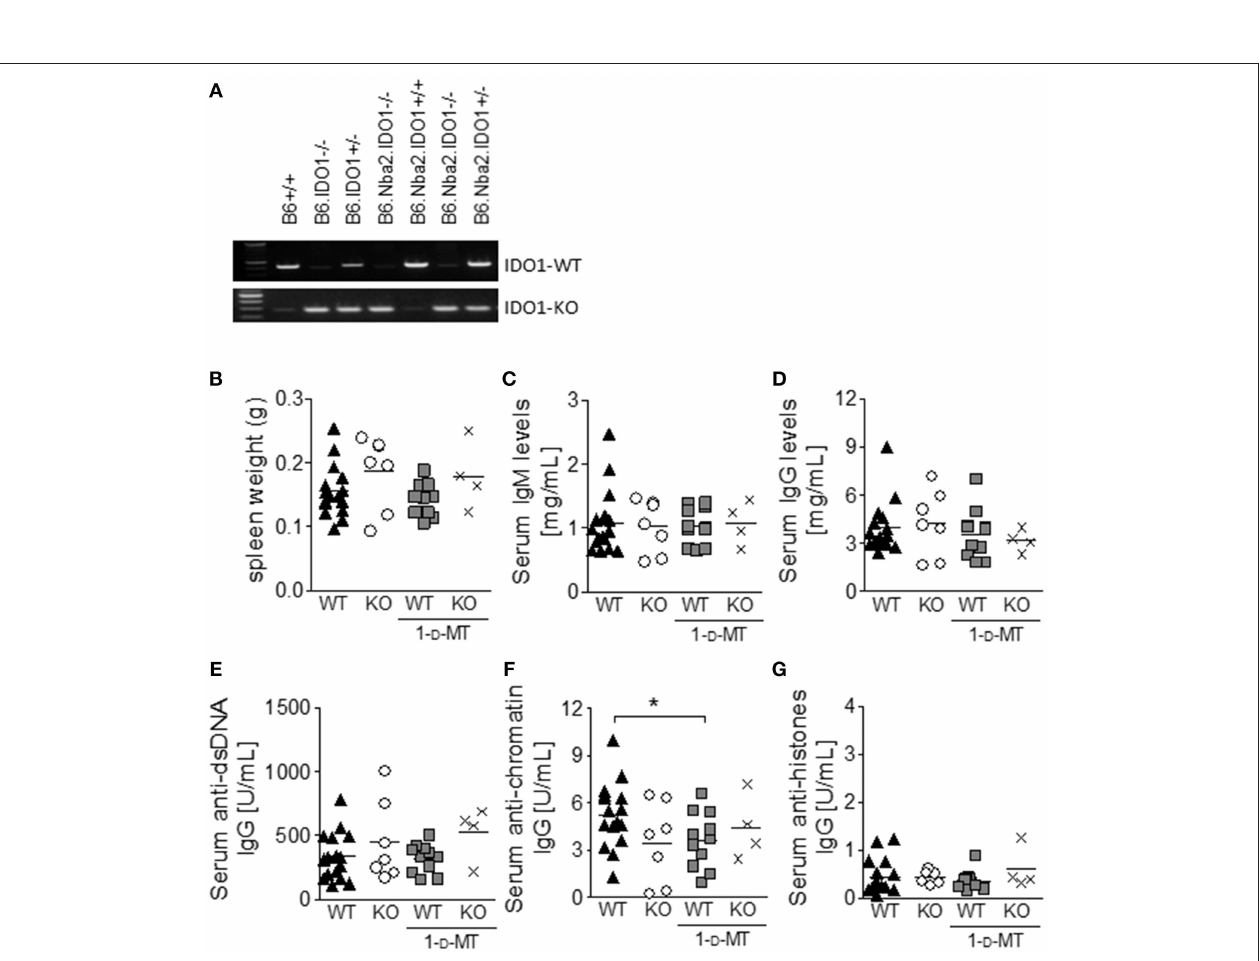
FIGURE 2 | IDO1-deficiency and/or 1- D -MT treatment do not affect the development of splenomegaly and autoantibody production in B6.Nba2 mice. IDO1-deficient and –sufficient B6.Nba2 mice were bred (A) and treated with PBS or 1- D -MT in the drinking water from 8 to 24 weeks of age. At 24 weeks of age, mice were harvested and spleen weights were recorded (B) . Serum was obtained monthly and evaluated for total IgM (C) , total IgG (D) , anti-dsDNA IgG (E) , anti-chromatin IgG (F) , and anti-histone IgG (G) . Shown are data from 24 week old mice. Each symbol represents one mouse. * p < 0.05, Student’s unpaired t -test with Welch’s correction.